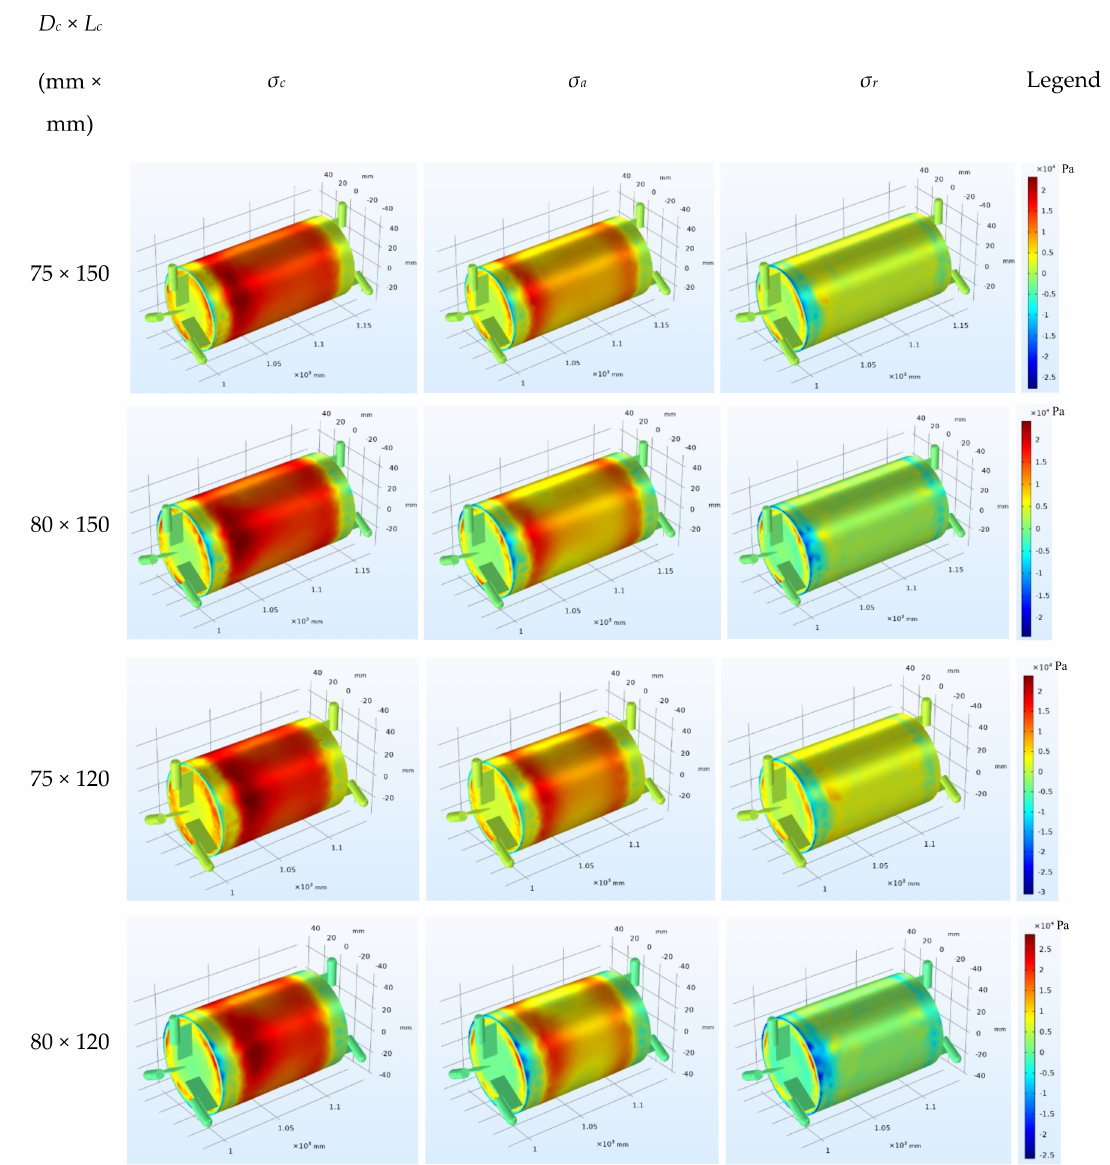
Figure 14. Principal stress distribution for di ff erent sizes of the piped carriage with the discharge of 50 m 3 · h − 1